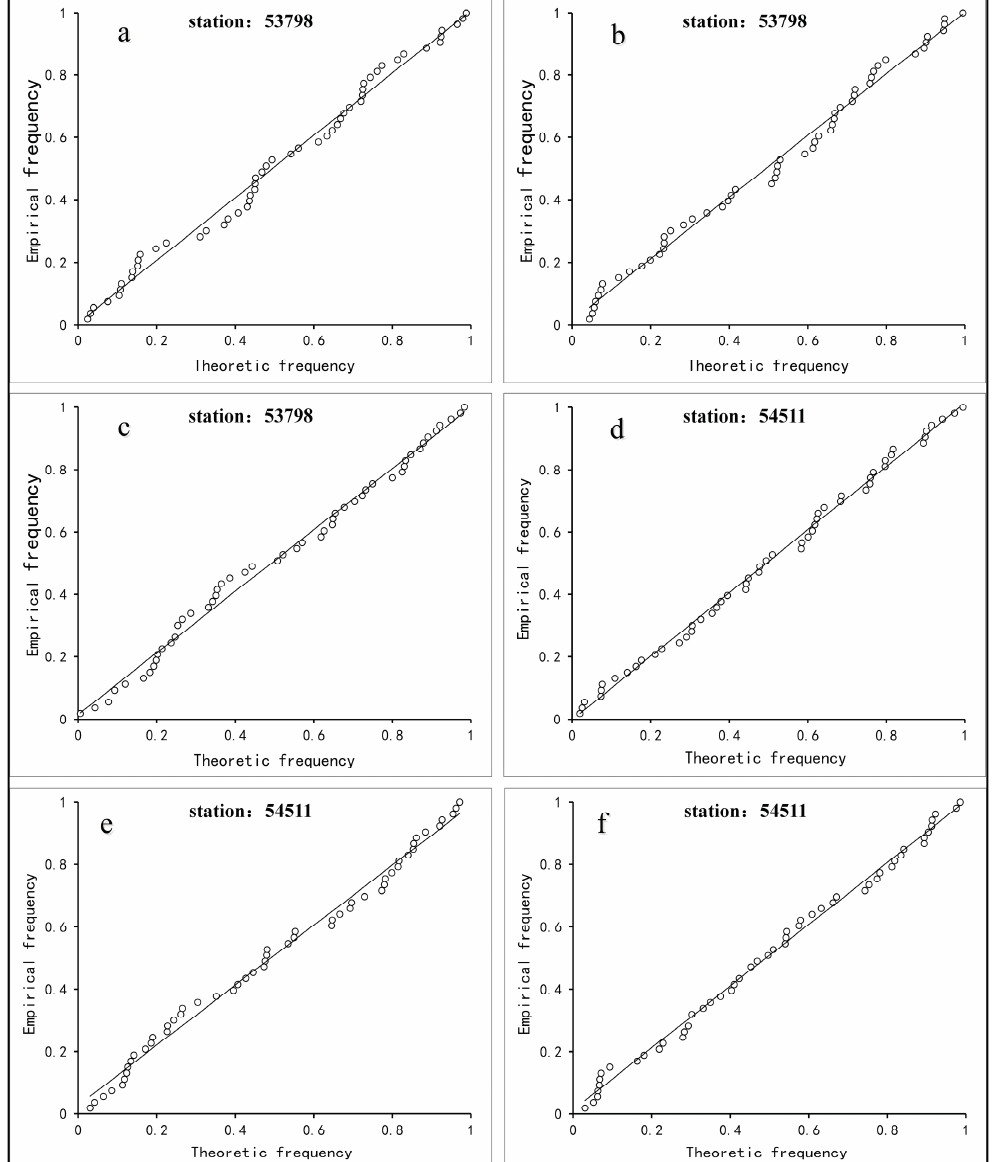
Figure 4. The comparison between empirical frequency and the best-fit distributions’ theoretical frequency of precipitation anomaly percentage at meteorological stations 53798 and 54511 (station 53798: ( a ) for spring; ( b ) for summer and ( c ) for autumn; station 54511: ( d ) for spring; ( e ) for summer and ( f ) for